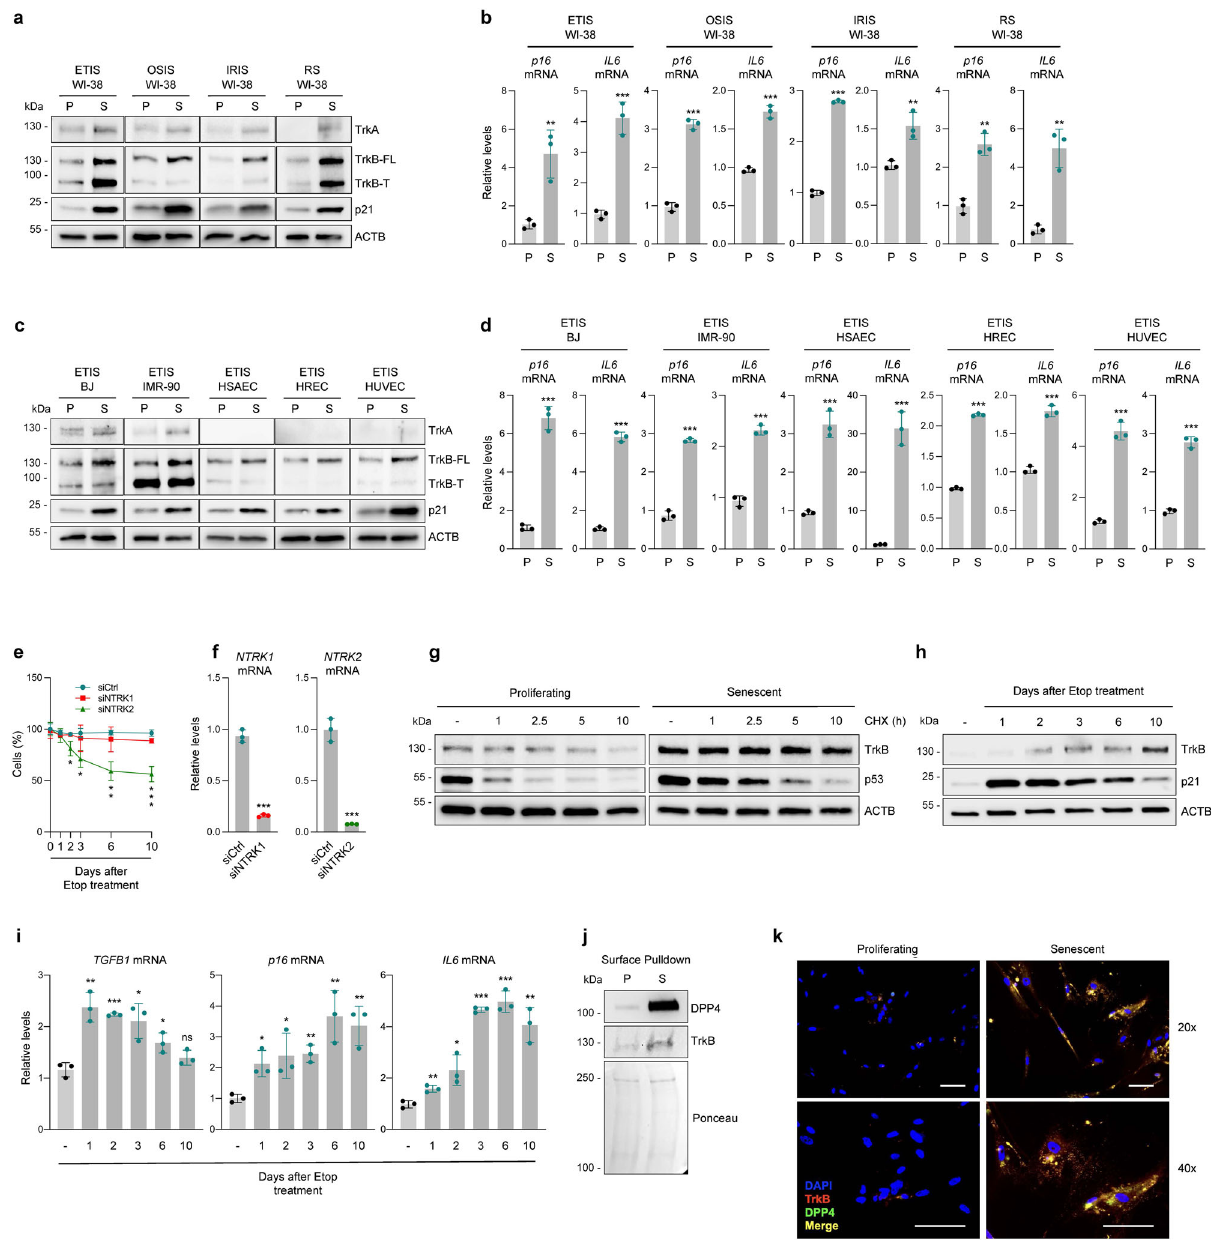
Fig. 3 | Increased TrkB levels in senescent cells promotes resistance to apoptosis. a , b In WI-38 fi broblasts that were proliferating (P) or undergoing senescence (S) (ETIS, OSIS, IRIS, RS as in Fig. 2c), western blot analysis was used to evaluate TrkA, TrkB full-length (FL), and truncated (T), p21, and ACTB ( a ), and RT-qPCR analysis to measure the levels of p16 and IL6 mRNAs ( b ). Western blot analysis( c )andRT-qPCRanalysis( d )ofthesamemoleculesasin a , b butmeasured in BJ and IMR-90 fi broblasts and in HSAECs, HRECs, and HUVECs rendered senes- cent by ETIS (S) as described in Fig. 2c or proliferating (P). e WI-38 cells were transfected with siCtrl, siNTRK1 (directed at TrkA), or siNTRK2 (directed at TrkB) and treatedwith etoposide(ETIS); % live cellsrelative to day0 were counted at the indicatedtimes. f RT-qPCRanalysisofthelevelsof NTRK1 and NTRK2 mRNAsatday 10 in the groups analyzed in e . g Western blot analysis of the levels of TrkB, labile proteinp53,andACTBinproliferatingandsenescent(ETIS)WI-38cellsatthetimes